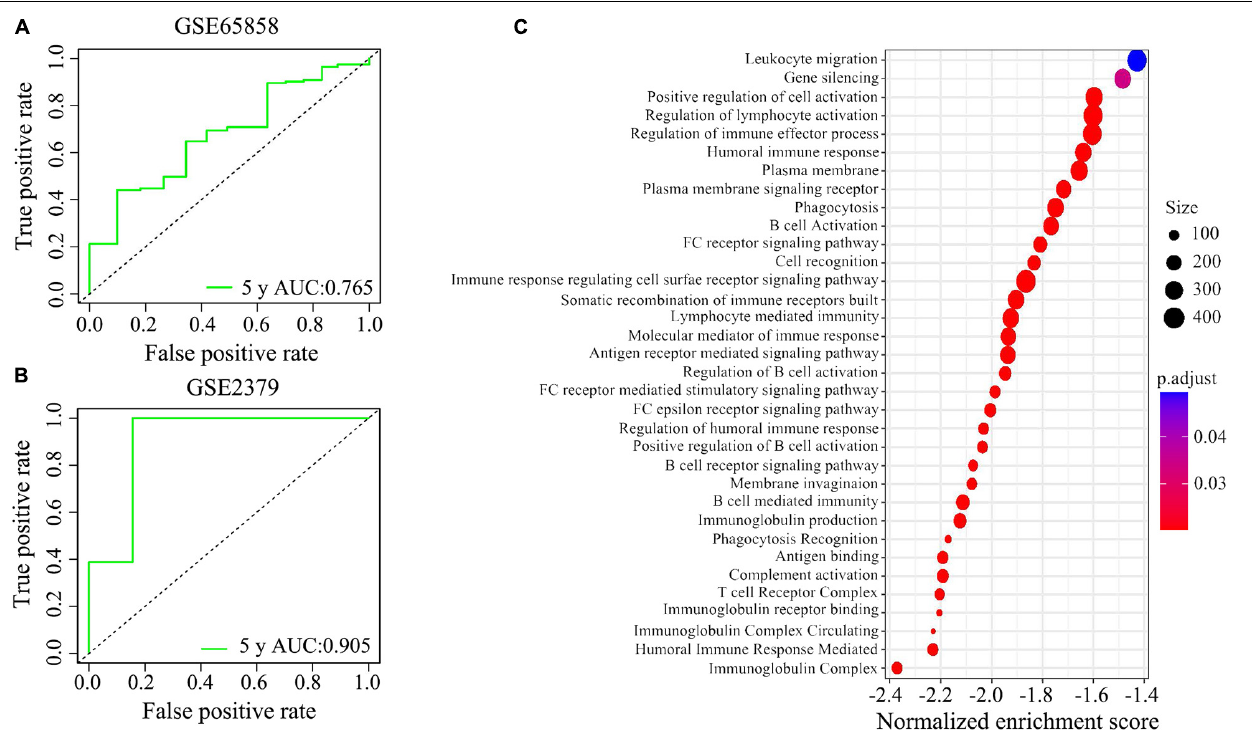
FIGURE 6 | The potential signaling pathways of the signature of IRGPs were explored by GEO enrichment analysis. (A,B) The receiver operating characteristic (ROC) curve illustrated the predictive ability of the 22 IRGPs signature. The areas under the curves for 5 years’ survival were 0.765 and 0.905 in two validation cohorts, respectively. (C) The signature of IRGPs in the TCGA cohort of HNSCC was involved in the positive regulation of cell activation, regulation of lymphocyte activation, regulation of immune effector process, humoral immune response, plasma membrane, and